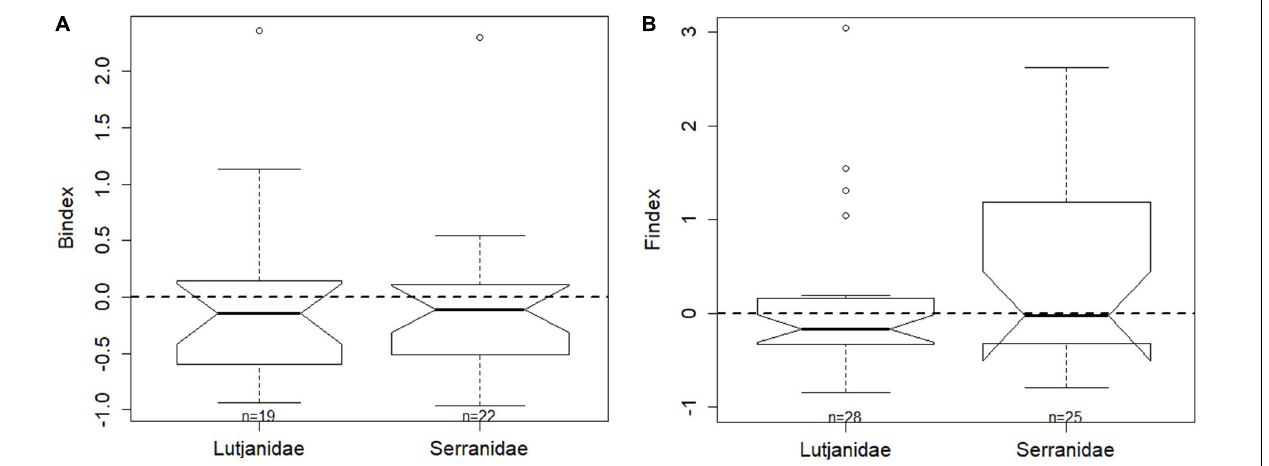
FIGURE 5 | Distribution of biomass and fishing mortality indices by family. (A) The biomass index (Bindex) was calculated based on the current biomass value (spawning stock biomass or other biomass proxies) in relation to the reference point [(SSB − SSB MSY )/SSB MSY ], and (B) the fishing pressure index (Findex) was calculated based on the current fishing mortality value (F or proxies) in relation to the reference point [(F − F MSY )/F MSY ]. The Findex y-axis is limited (5 outliers above limit = 3: yellowtail snapper Ocyurus chrysurus – NE Brazil, coney Cephalopholis fulva and vermillion snapper Rhomboplites aurorubens – Puerto Rico, orange-spotted grouper Epinephelus coioides – Oman and United Arab Emirates). Extreme high values for Bindex are from yellowtail snapper Ocyurus chrysurus (Northern Gulf of Mexico and Western Central Atlantic) and peacock hind Cephalopholis argus (Hawaii), while the highest Findex value is from gray snapper Lutjanus griseus (Puerto Rico) fisheries.